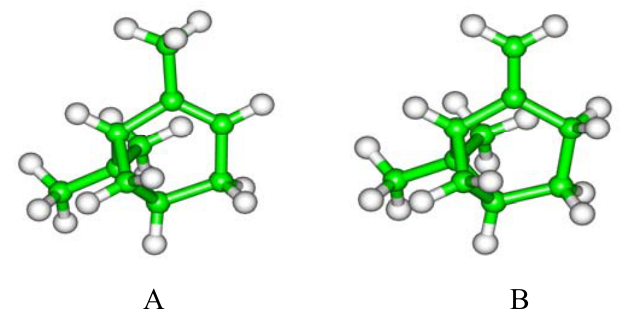
Figure 1. Structures of (-)- α -pinene (A) and (-)- β -pinene